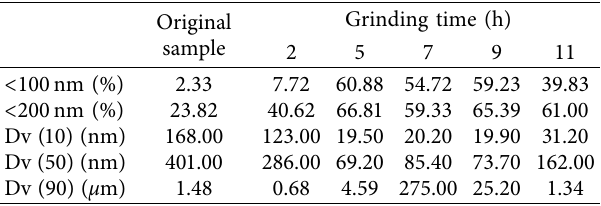
Table 2: Particle sizes of dispersed orange 31 with diferent grinding